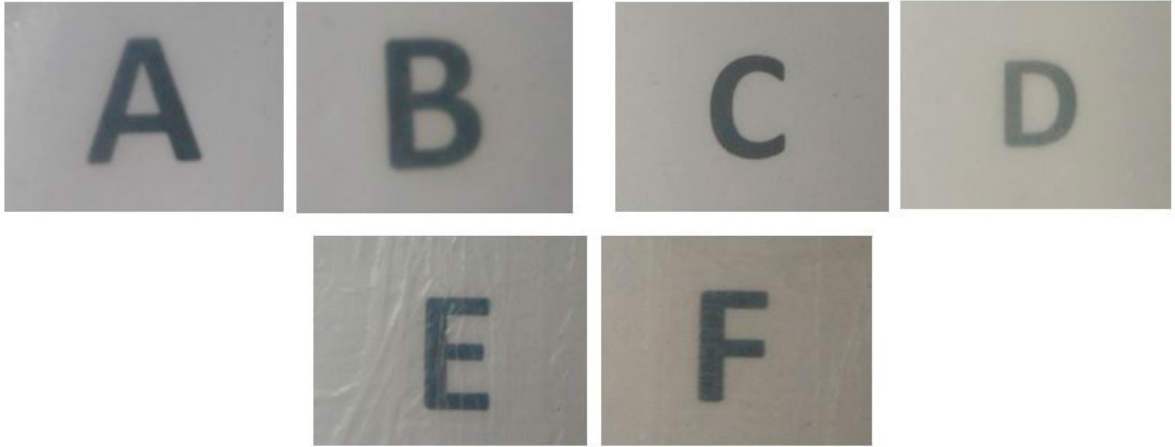
Figure 3. Contact transparency pictures of the multilayers made of ( A ) poly(3-hydroxybutyrate- co -3-hydroxyvalerate) containing 8 mol.% 3-hydroxyvalerate (PHBV8) without cellulose nanocrystals (CNCs), ( B ) PHBV8 with CNCs, ( C ) PHBV with 2 mol.% 3-hydroxyvalerate (PHBV2) without CNCs, ( D ) PHBV2 with CNCs, ( E ) poly(3-hydroxybutyrate) with poly(butylene adipate- co -terephthalate) blend (PHB Blend) without CNCs, and ( F ) PHB Blend with CNCs. Letters were placed underneath the films to assess their contact transparency.